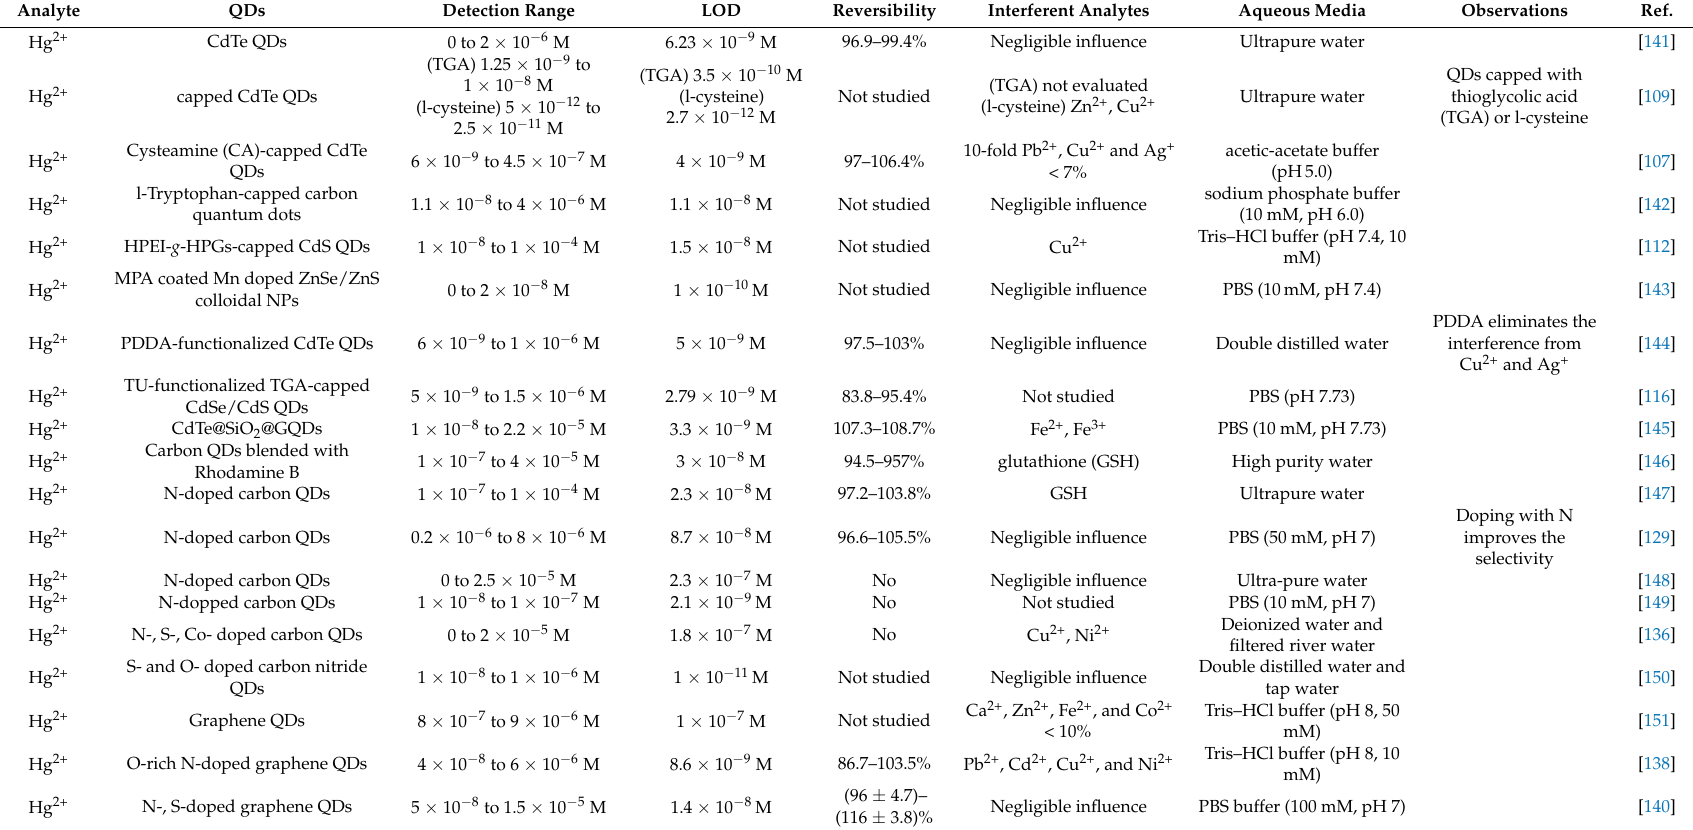
Table 3. Hg 2+ fluorescent sensors based on